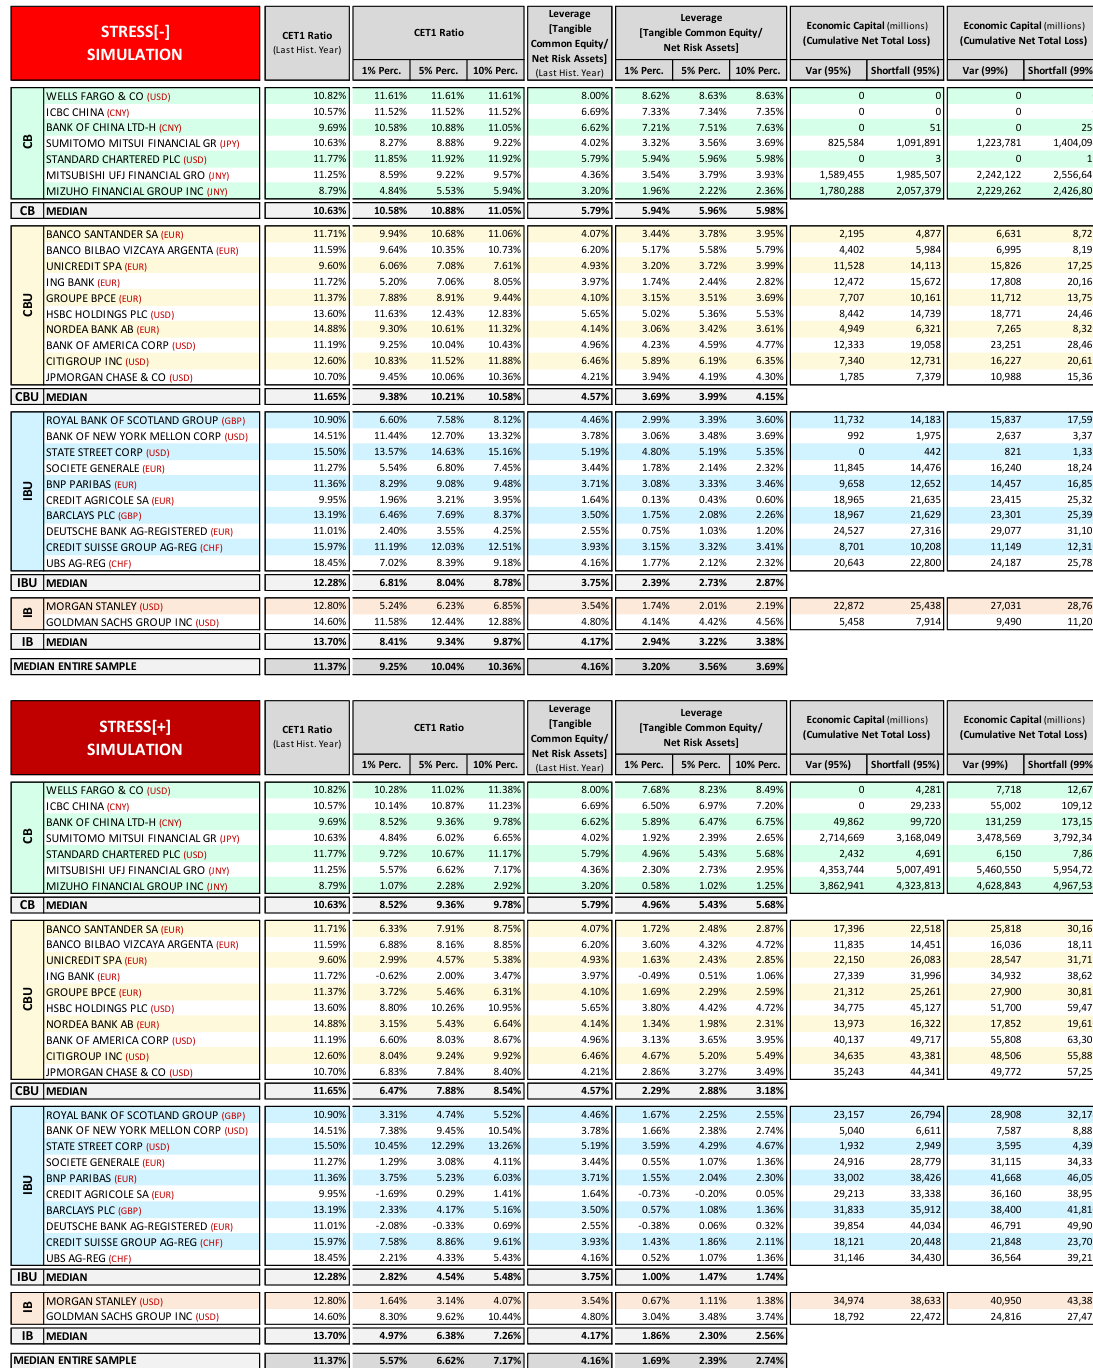
1% Perc. 5% Perc. 10% Perc.